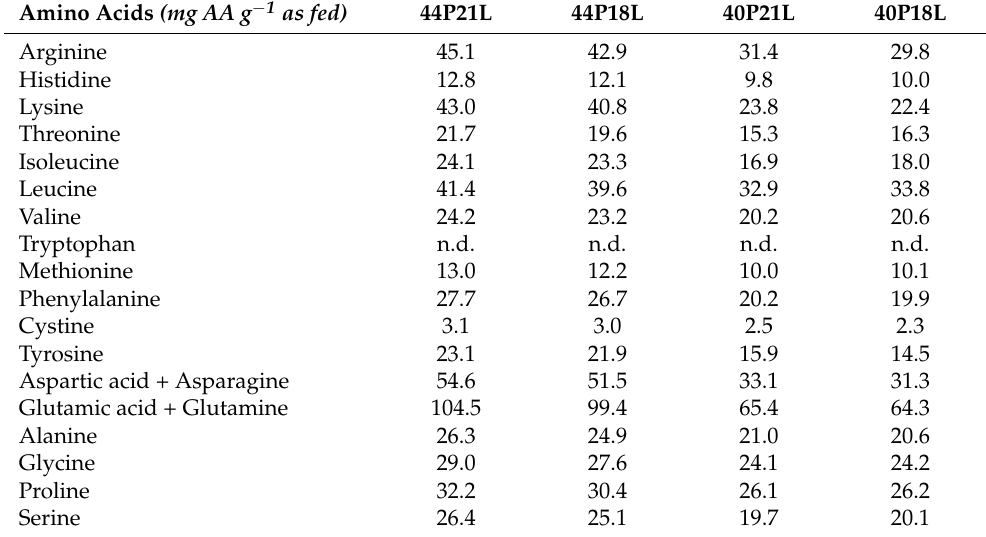
Table 2. Amino acid composition of experimental diets. Amino Acids (mg AA g − 1 as